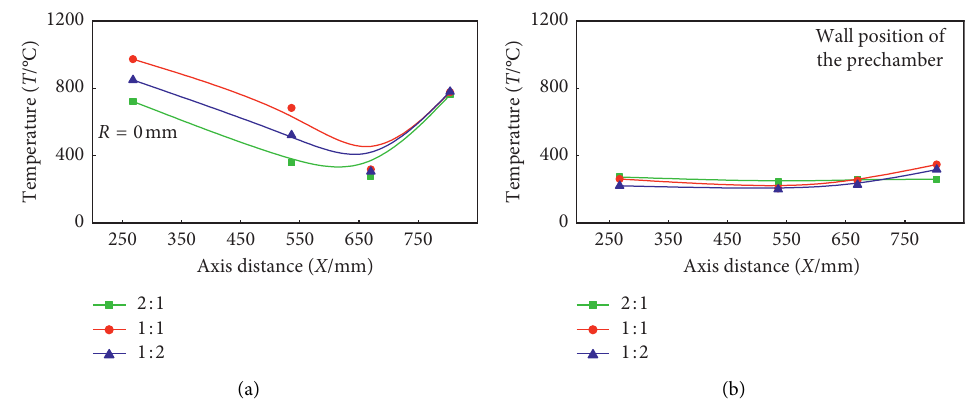
Figure 4: Temperature profiles along axis distance for different ISA/OSA.